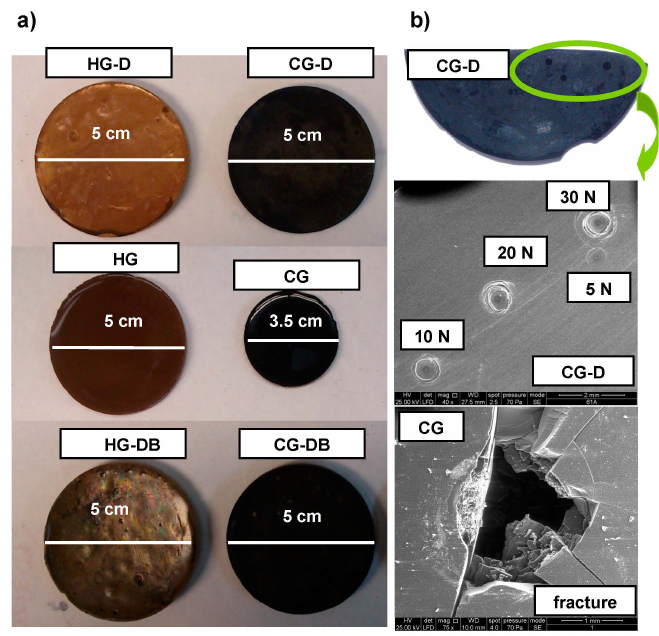
Figure 6. ( a ) Images of the studied monolithic aerogels showing the characteristic shrinkage upon carbonization and ( b ) examples of the characteristic fingerprints of the aerogels after different loadings. Table 3. Shrinkage after carbonization (in C-series) of the aerogels and response to the Crushing Strength Tests. The initial dimensions of all the specimens were ca. 5